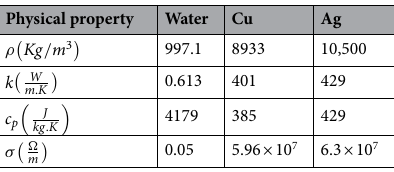
Table 2. Thermal properties of water, copper and